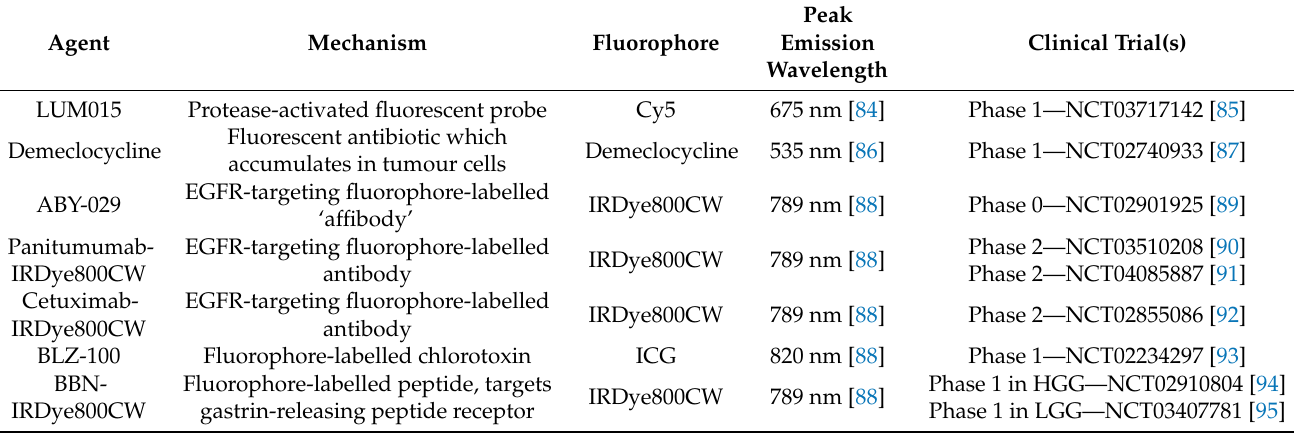
Table 1. Summary of novel fluorescent agents currently undergoing clinical trials in glial